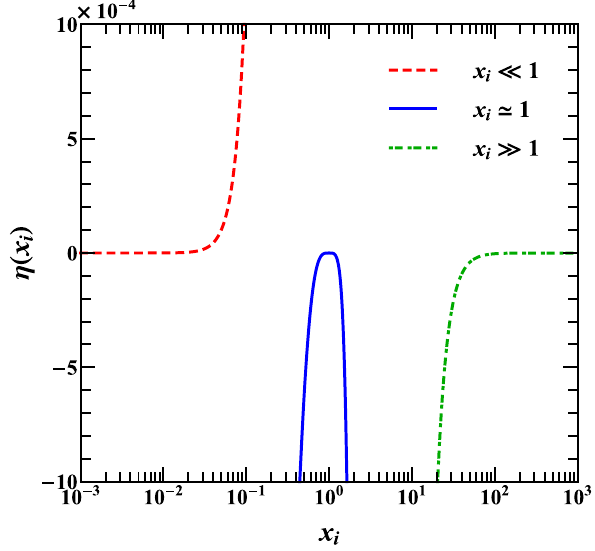
(cid:25) (cid:24) x between i (cid:3) 10 have been i (cid:9) 1, x (cid:5) 1 and i i